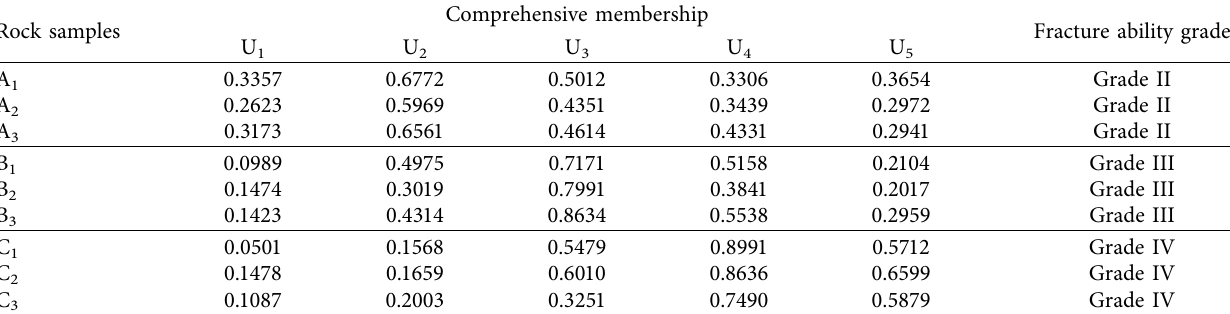
Table 11: Fracture ability classification results of rock mass. Rock